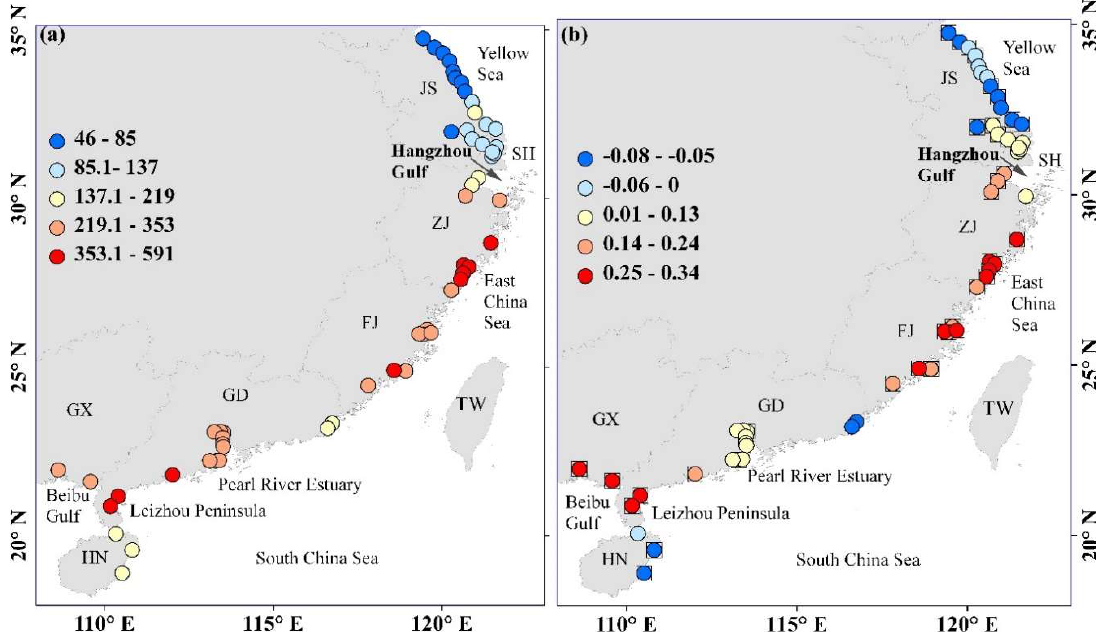
Figure 4. ( a ) Sum of ASPI in each tide-gauge station from 1960 to 2015. ( b ) ASPI trend of individual tide-gauge stations along the southeastern coastline of China from the 1990s. Square marks indicate that the p-value of the increasing rate is smaller than 0.05. The capital letters represent the names of